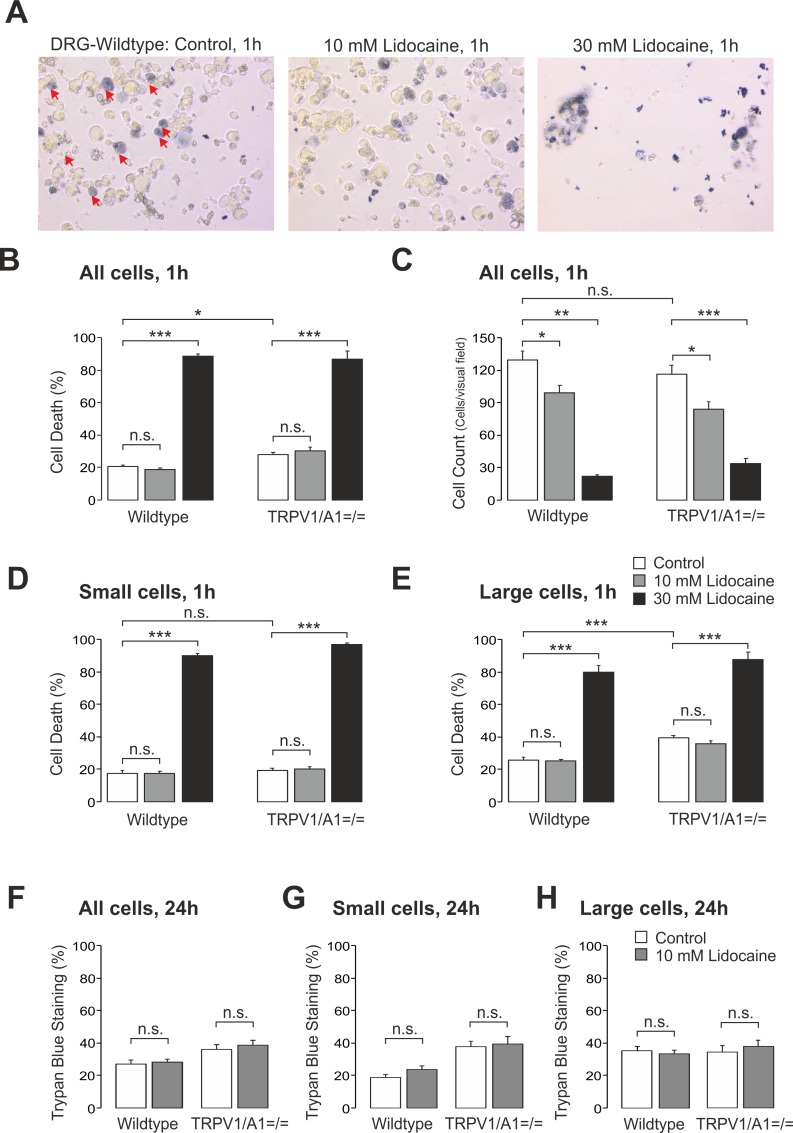
Lidocaine-evoked neurotoxicity does not involve TRPA1 or TRPV1 in DRG neurons.A. Representative phase contrast photographs (20x) of cultured DRG neurons stained with trypan blue (0.04%) following treatment with control solution (left, red arrows indicate cells stained with trypan blue), 10 mM lidocaine (middle) or 30 mM lidocaine (right). B, D-H. Bar columns displaying the mean percentage of dead DRG neurons from wild type or TRPV1/TRPA1 = / = mice (i.e. cells stained with trypan blue) before and 1 h or 24 h after treatment with 10 or 30 mM lidocaine. The cytotoxic effect of lidocaine was compared between the two genotypes in respect to all (B, F), to small (<30 μm, D, G) and to large (>30 μm, E, H) sized DRG neurons. C. Bar columns displaying the mean numbers of DRG neurons (counts/visual field) from wild type or TRPV1/TRPA1 = / = mice following treatment with 10 and 30 mM lidocaine. Data are presented as mean ± S.E.M. * indicates p< 0.001, *** indicates p< 0.001, n.s. not significant due to calculation with ANOVA followed by HSD post-hoc test.